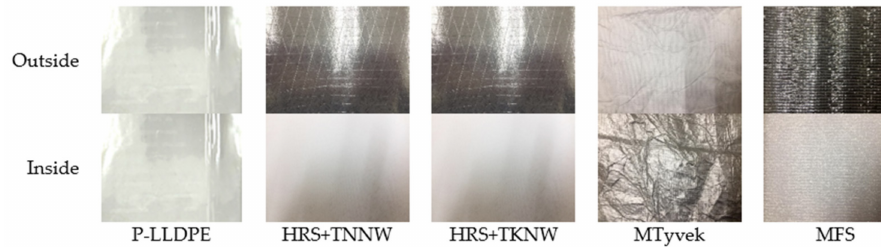
Figure 1. Five insulation materials as treatments.